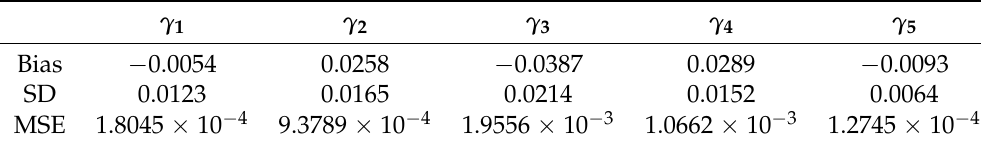
Table 2. Bias, SD and MSE evolutions with respect to the parameter γ variation for GNFPLSIM with the identity link function and n = 500.